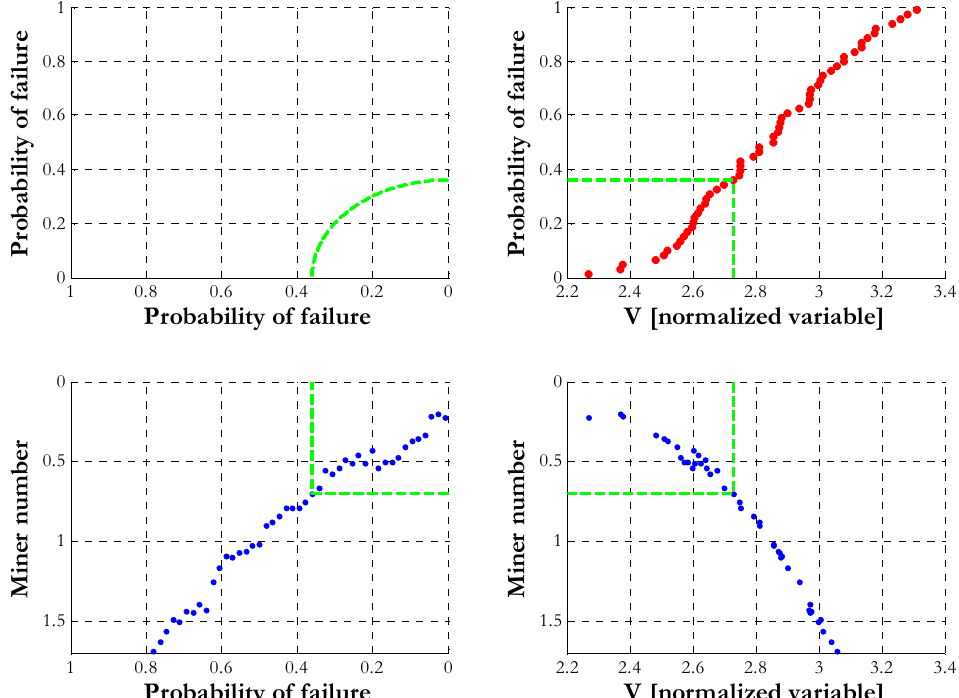
Figure 7: From the experimental Weibull cumulative distribution function for the normalized variable V (upper-right) and the established relation between V and M (down-right), the experimental cdf of the Miner number (down-left) is found for the fatigue of Holmen